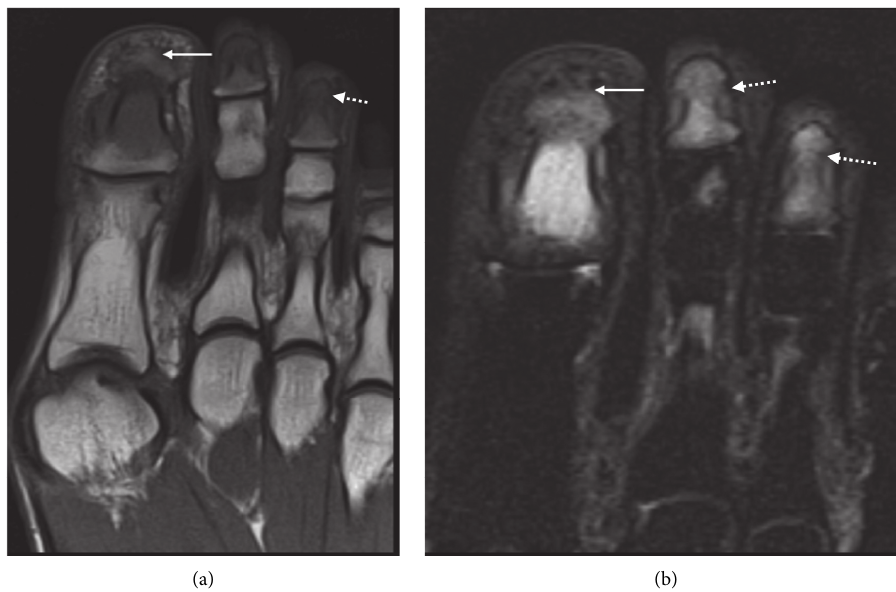
Figure 12: Coronal forefoot T1 (a) and STIR (b) sequence of a 45-year-old female with Raynaud phenomenon. There is an altered marrow signal (A dotted arrow) with oedema signal (b dotted arrow) in the distal phalanges involving noncontiguous bone. There is an impression of early tuft resorption involving the great toe (arrow), with an ill-defined